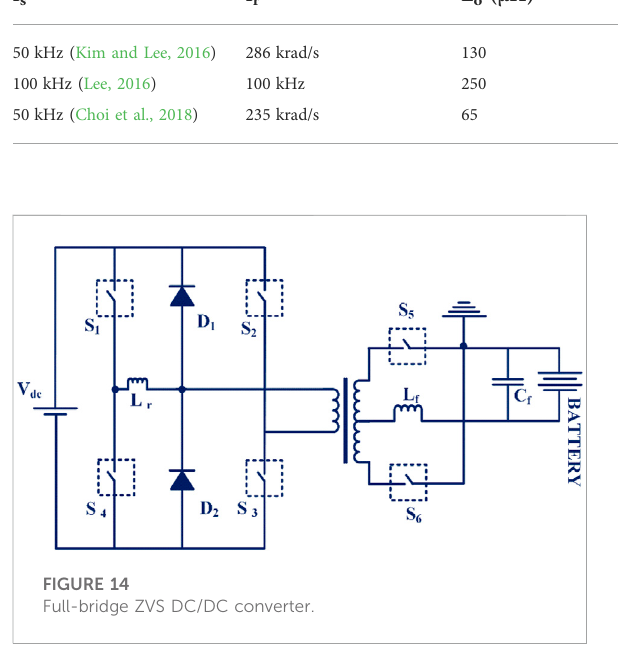
FIGURE 14 Full-bridge ZVS DC/DC converter.